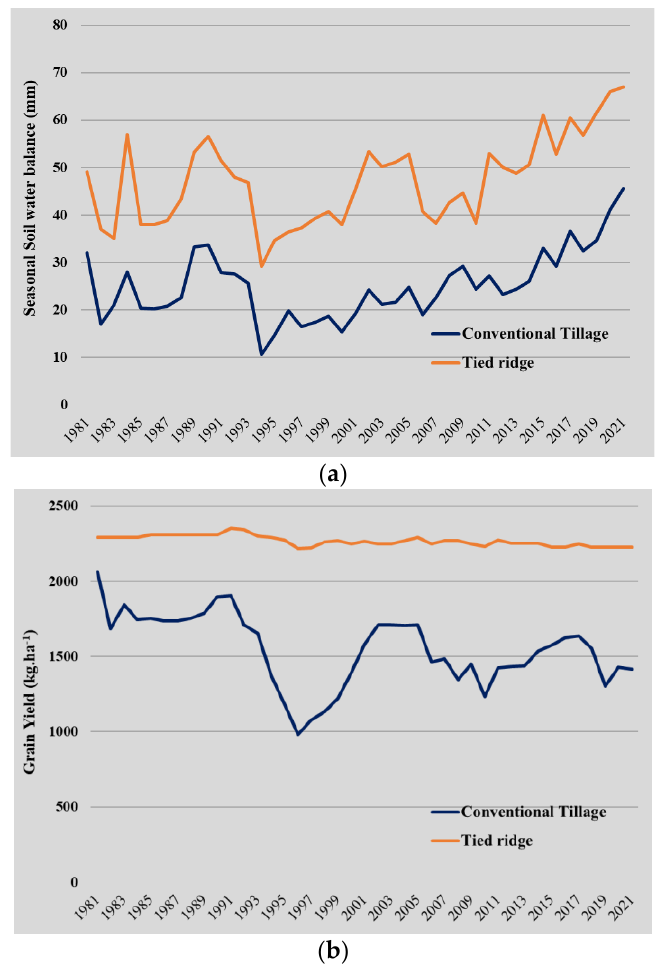
Figure 5 . Simulated soil water balance ( a ) and grain yield ( b ) for the reference period (1981 – 2021) .